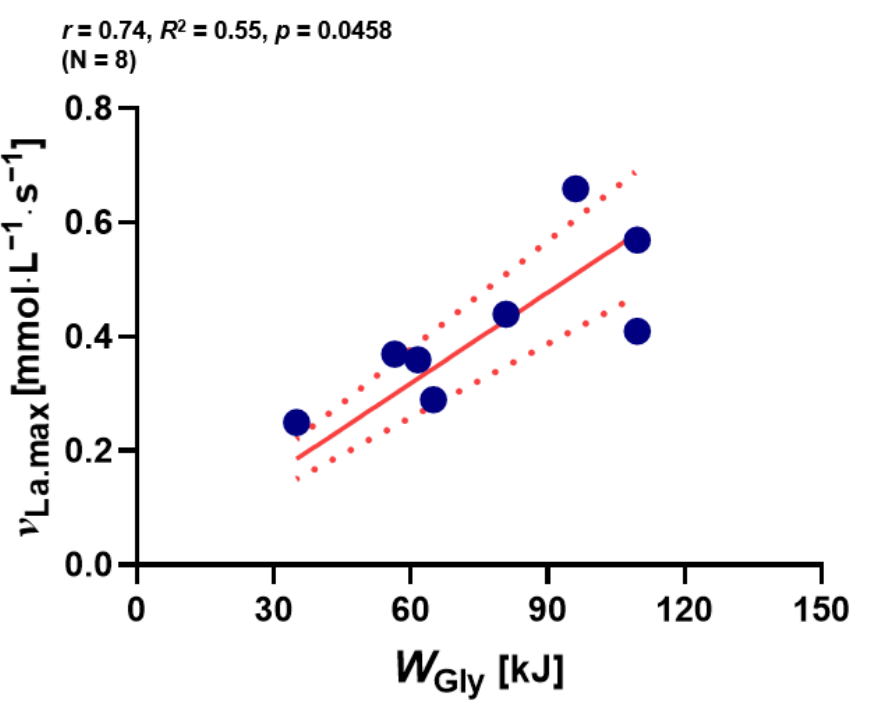
Figure 3. Relationship between ν La.max and W Gly ( n = 8). ν La.max : maximum rate of lactate accumulation, W Gly : glycolytic energy contribution. Dotted lines: 95% confidence interval, straight line: strength of the linear relationship between two variables.